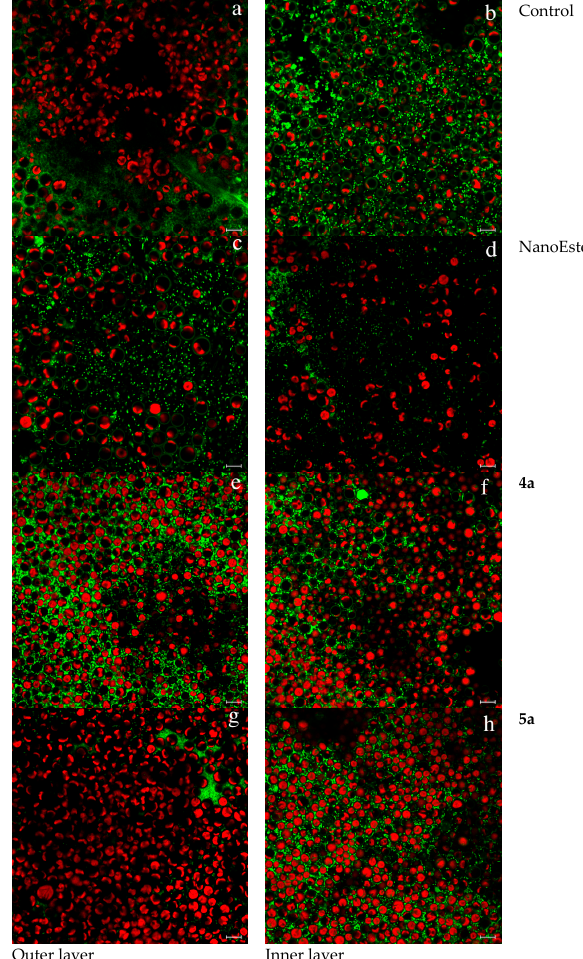
Figure 4. Biofilm behavior on tufa after 90 days of incubation, of untreated samples, samples with only consolidant and with coating treated with compounds 4a and 5a . Inner and outer layer showed a diverse distribution of microbial members of the biofilm. The different groups are well recognizable being algae colored in red, bacteria in green, while black fungi appear as black areas between the colored cells. Outer and inner layers of biofilm: ( a , b ) in the untreated probe it is observed an abundant and healthy biofilm; ( c , d ) similar behavior on probes treated only with NanoEstel; ( e , f ) on areas treated with 4 and ( g , h ) with 5a an increase of growth of the biofilm was observed, even more intense than the untreated control. Detailed explanations are given in the text. Bar is 10 μ m.